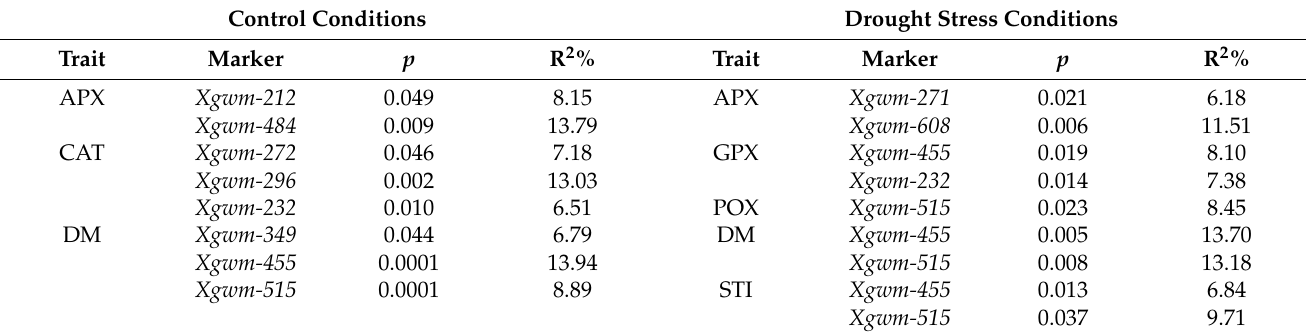
Table 3. The list of significant marker–trait associations under the control and drought stress conditions. Control Conditions Drought Stress